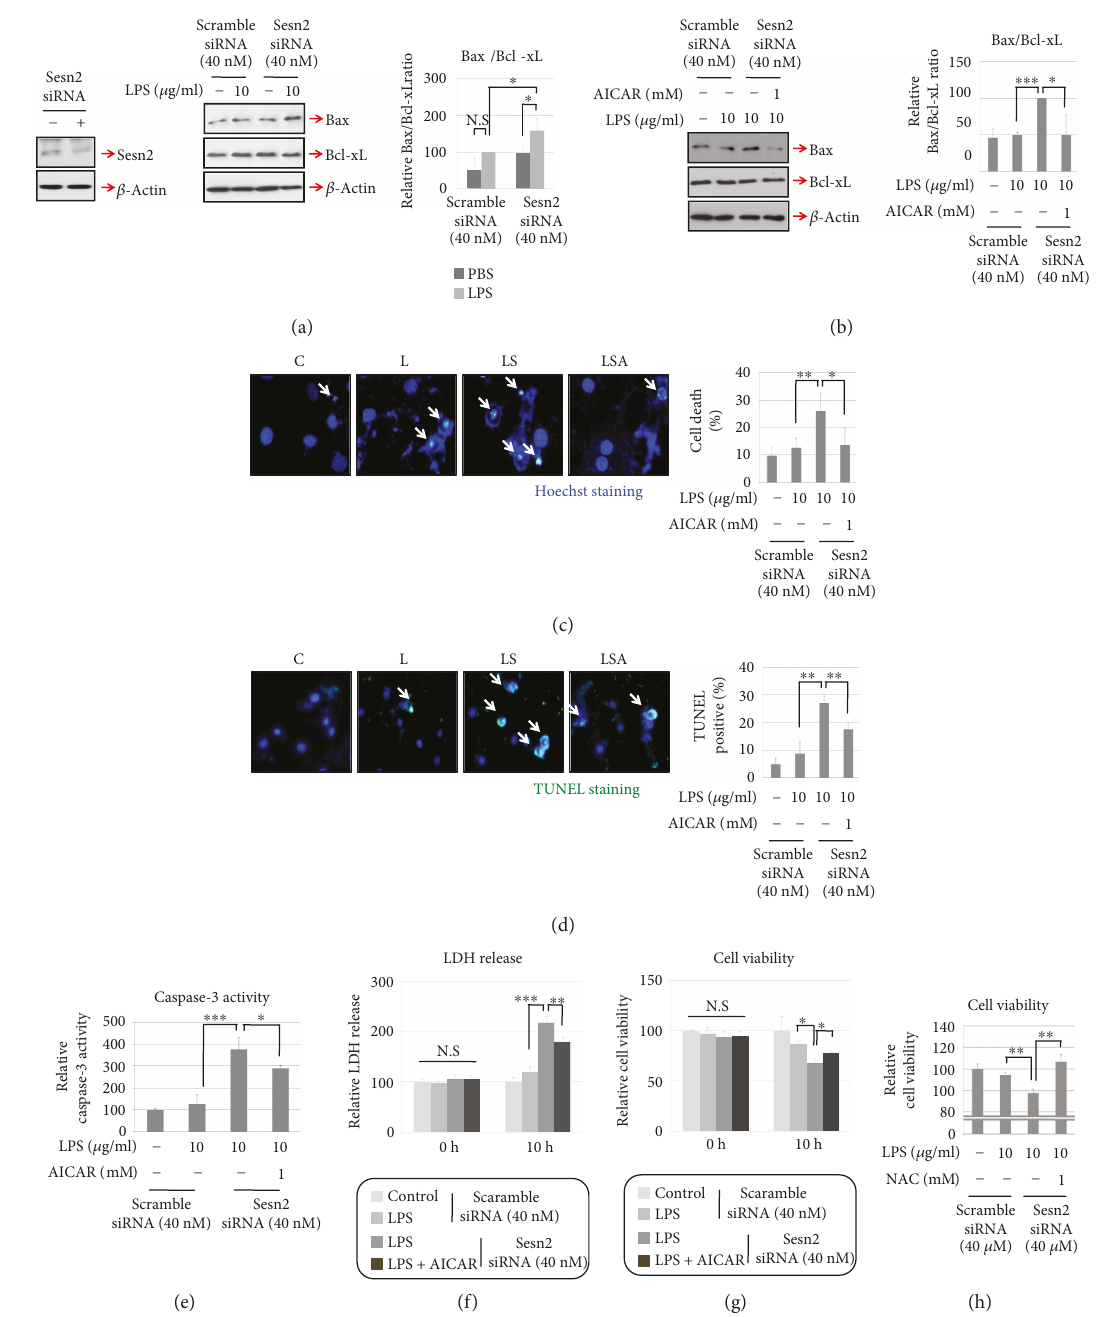
Figure 2: H9c2 cell viability is decreased by sesn2 knockdown upon LPS treatment. (a and b) Sesn2 knockdown H9c2 cells were incubated with LPS or LPS plus AICAR for 6 h, after which the ratio of Bax to Bcl-xL was determined by Western blotting. (c) Sesn2 knockdown cells were stimulated with LPS or LPS plus AICAR for 10 h, after which nuclei were observed by Hoechst staining (blue). (d) TUNEL-negative cells (only blue) and TUNEL-positive cells (blue plus green) were counted under a fl uorescence microscope from the 4 fi elds of view randomly selected in each well, and then representative images were obtained for each group. (e) Caspase-3 activity in H9c2 cells was measured using a Caspase-3 Activity Assay Kit. (f) LDH release and (g) cell viabilities were calculated using a LDH assay reagent and cell viability assay reagent. (h) Sesn2 knockdown H9c2 cells were incubated with LPS or LPS plus NAC for 10 h, after which cell viabilities were measured. All graphs were obtained from more than three independent experiments. Data are presented as means; error bars represent ± SD (NS: not signi fi cant; ∗ P < 0 05 ; ∗∗ P < 0 005 ; ∗∗∗ P < 0 0005 ;